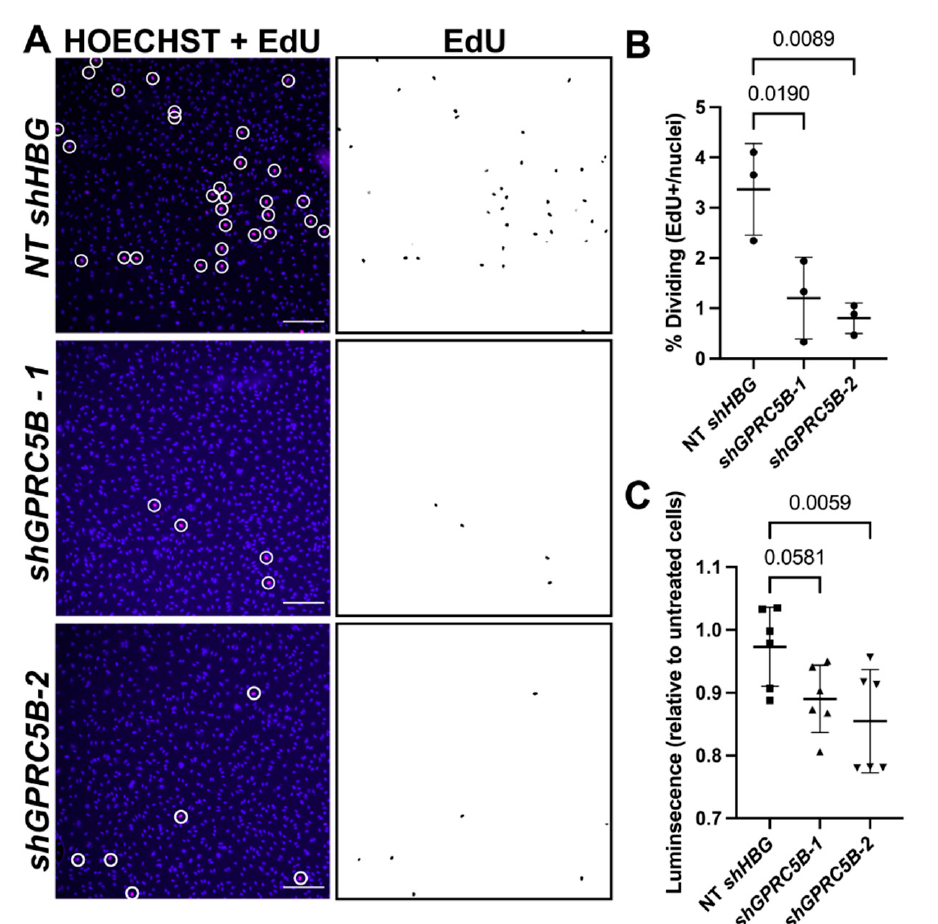
Figure 7. hGPRC5B -deficient human lymphatic endothelial cells are less proliferative and less viable compared to control cells. ( A ) Immunofluorescence of human dermal lymphatic endothelial cells treated in vitro with non-targeting control shRNA or shRNA targeting GPRC5B . Left column: red puncta encircled in white indicate Edu-positive cells. Right column: monostaining of EdU-positive nuclei. ( B ) Quantification of EdU-positive lymphatic endothelial cells. ( C ) CellTiter-Glo cell viability assay where luminescence indicates viable cells. Significance calculated using one-way ANOVA with correction for multiple comparisons. Scale bar = 50 µm.